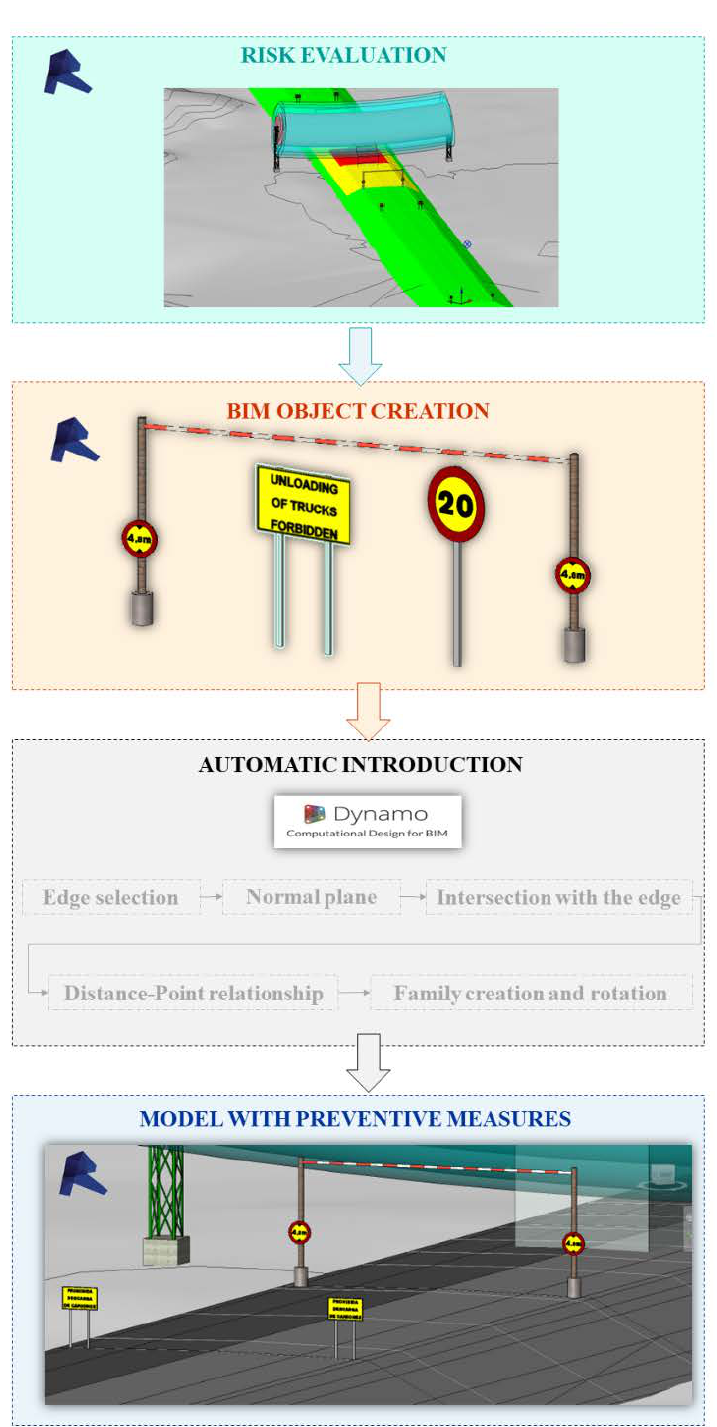
Figure 7. Creation of parametric BIM objects representing preventive measures according to the risk assessment and automation of their introduction into the model.